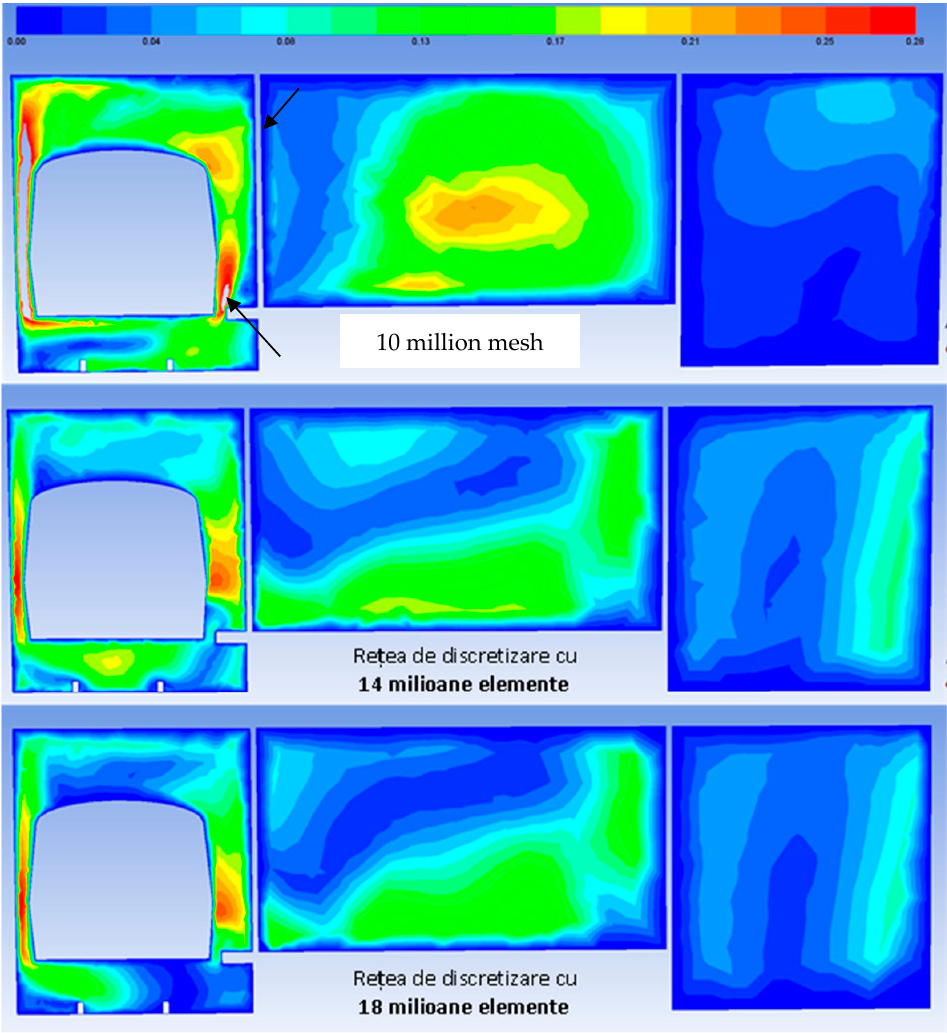
Figure 11. Air velocity fields (m/s) for the three considered meshes